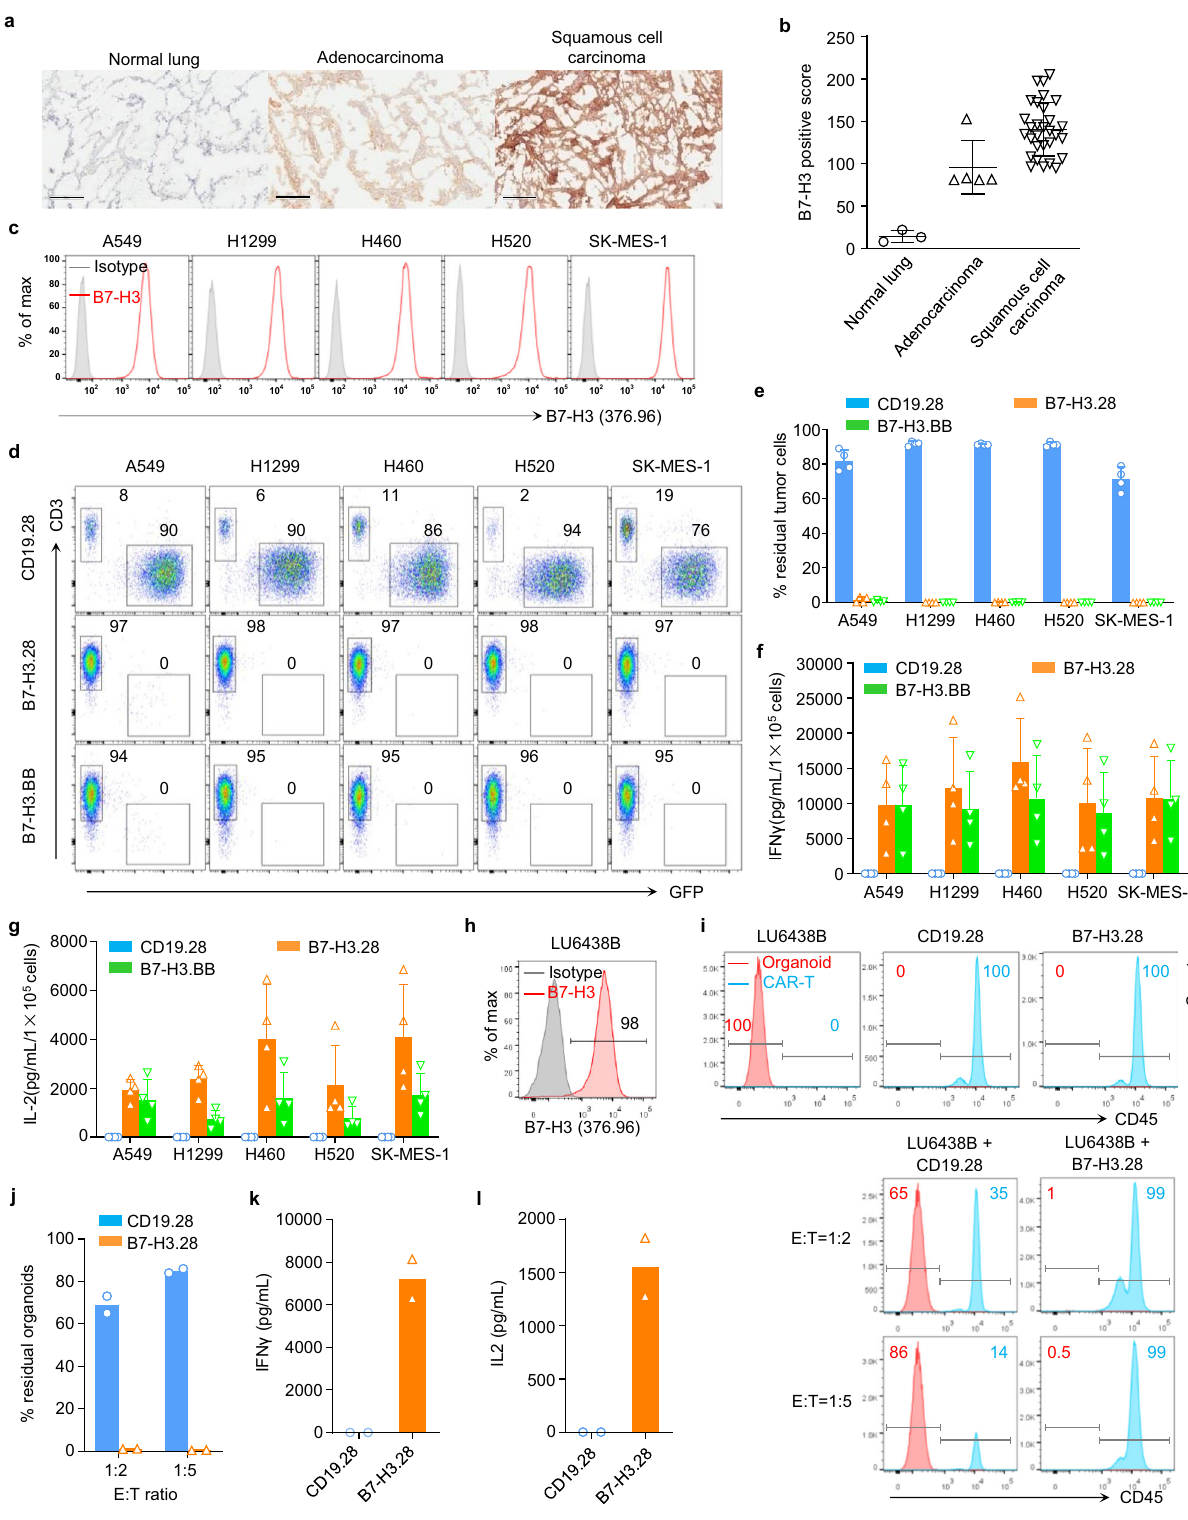
to the control non-transduced T cells (NT) and B7-H3.28 or B7- H3.BB CAR-T cells (Fig. 3e, f), while these cells retained similar expansion rate and phenotypic composition of central-memory, effector-memory, and T stem cell memory (Supplementary Fig. 5a – d). CCR2b overexpression conferred increased migration of CCR2b.B7-H3.28 and CCR2b.B7-H3.BB CAR-T cells toward